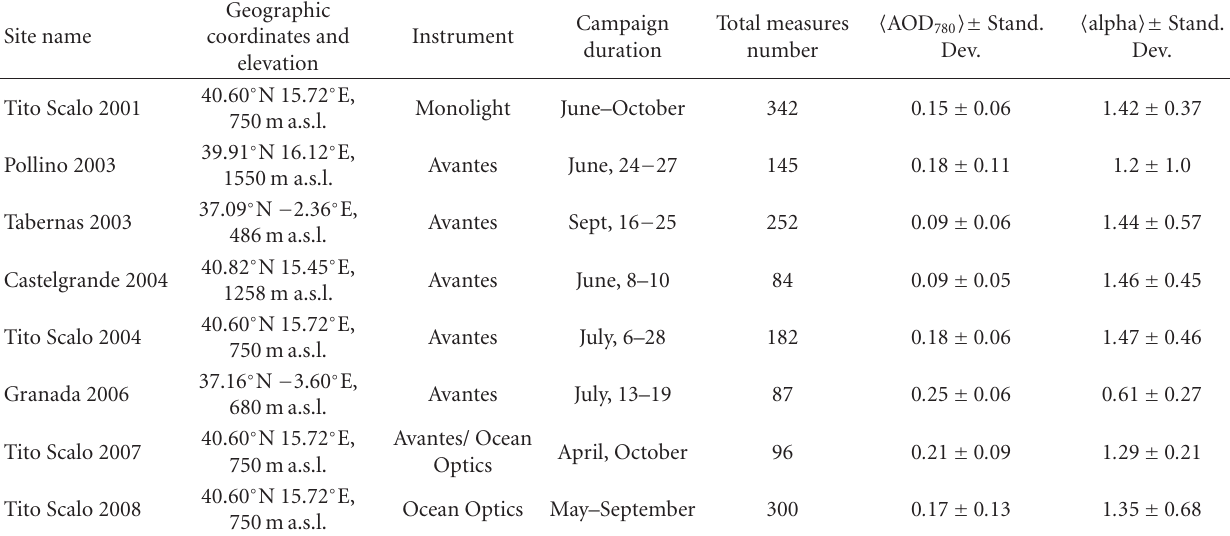
Table 1: List of the measurement campaigns with site, geographic coordinates and elevation, instrument used, duration, number of measurements, mean AOD at 780 and standard deviation, mean alpha, and standard deviation.